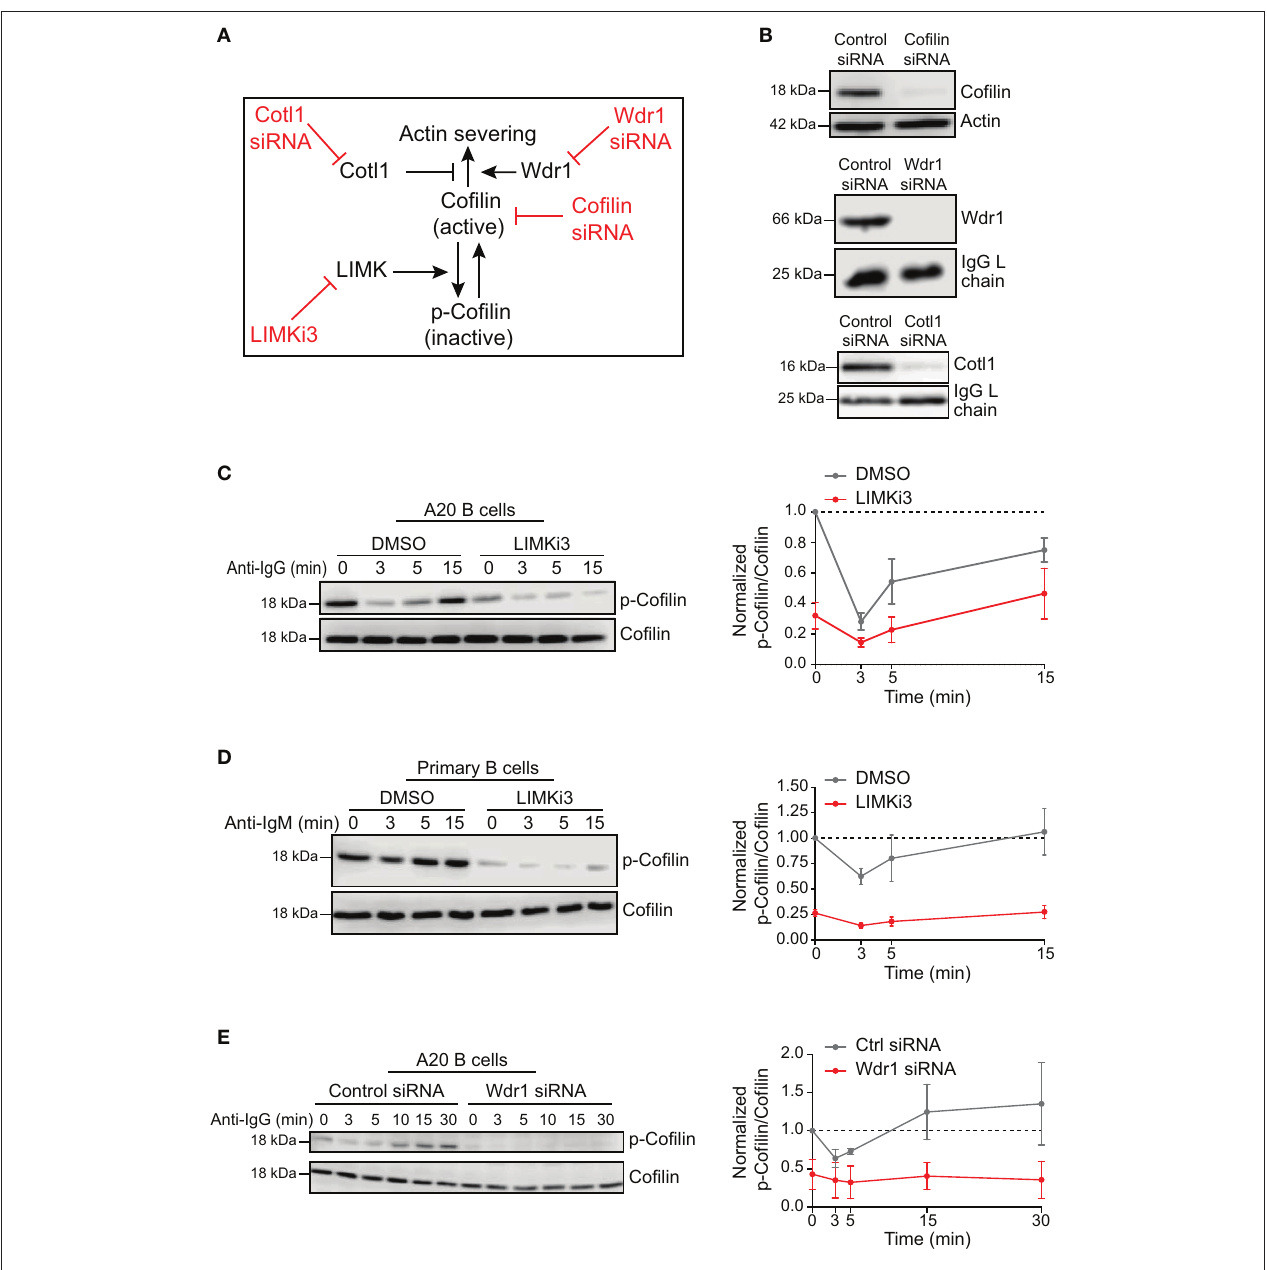
FIGURE 1 | Loss-of-function approaches for modulating cofilin activation and cofilin-mediated actin severing. (A) To complement siRNA-mediated depletion of cofilin, cofilin activation was enhanced by inhibiting LIMK, which phosphorylates cofilin on S3. The ability of cofilin to sever actin filaments was modulated by depleting either Wdr1 or Cotl1. (B) A20 B cells were transfected with control non-targeting siRNA, cofilin siRNA, Wdr1 siRNA, or Cotl1 siRNA. Cell extracts were analyzed by immunoblotting. Loading controls were actin or the endogenous Ig light (L) chain of the A20 B cells. Representative blots are shown. (C–E) In C, A20 B cells were pre-treated with DMSO or 50 µ M LIMKi3 for 1h before being stimulated with 20 µ g/mL anti-IgG for the indicated times. In (D) , primary murine B cells were pre-treated with DMSO or 1 µ M LIMKi3 for 1h before being stimulated with 20 µ g/mL anti-IgM. In (E) , A20 B cells that had been transfected with control siRNA or Wdr1 siRNA were stimulated with 20 µ g/mL anti-IgG. Representative p-cofilin and total cofilin immunoblots are shown (left panels). The p-cofilin/total cofilin ratios were normalized to the ratio in unstimulated (0min) control cells ( = 1.0). The means ± SEM from three independent experiments are graphed for each time point (right